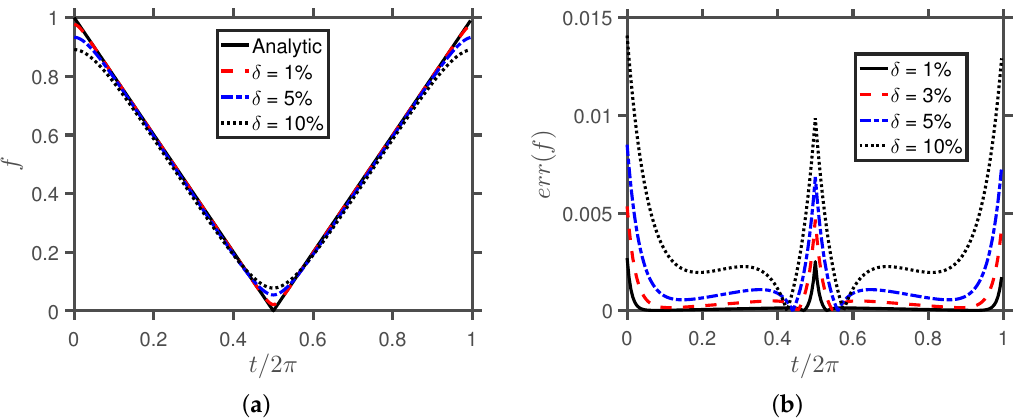
Figure 4. The numerical solutions of the temperature and the relative errors obtained using the presented method, and various amounts of noise added in the boundary data for Example